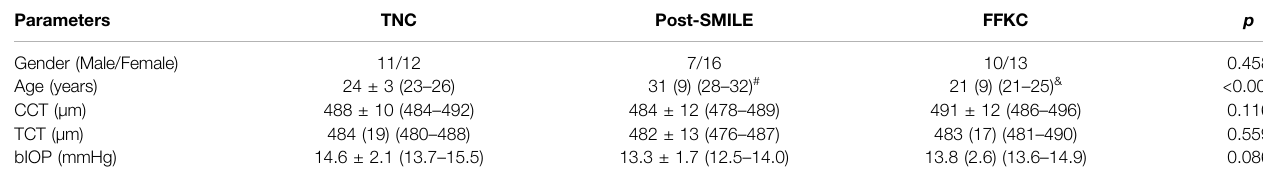
TABLE 2 | Baseline information of eyes by group after CCT matched. Parameters